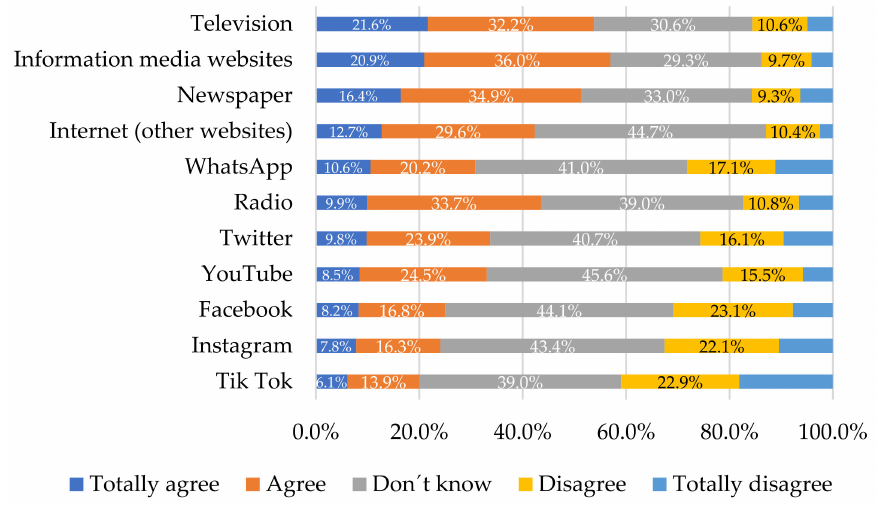
Figure 3. Distribution of percentages of responses to reliability in the